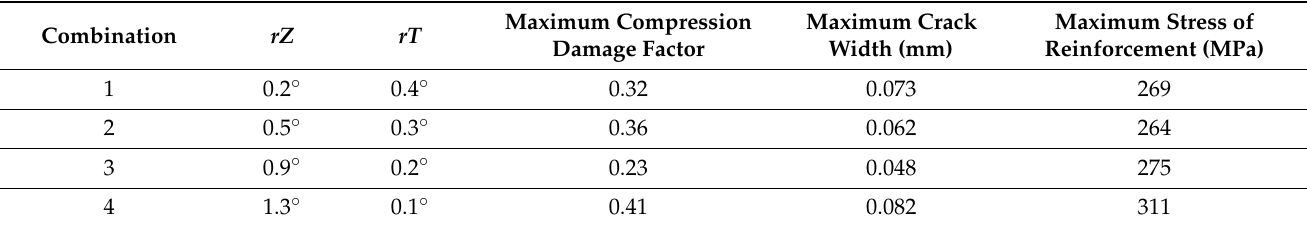
Table 8. Combined results of errors in the rZ and rT